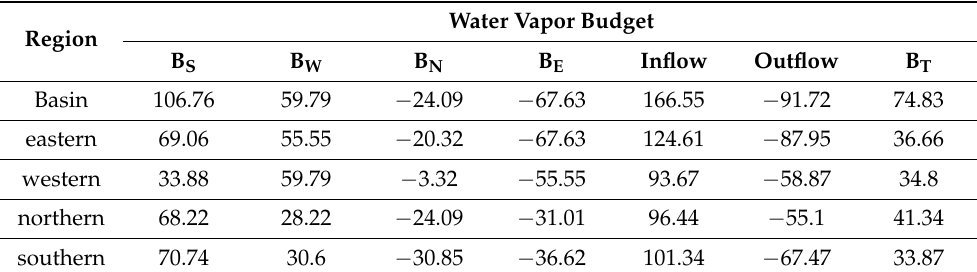
Table 1. The net water vapor transport, total inflow, total outflow, and the net budget at all boundaries in the Sichuan Basin (the eastern, western, northern and southern basin) in summer (unit: 10 6 kg s − 1 ).